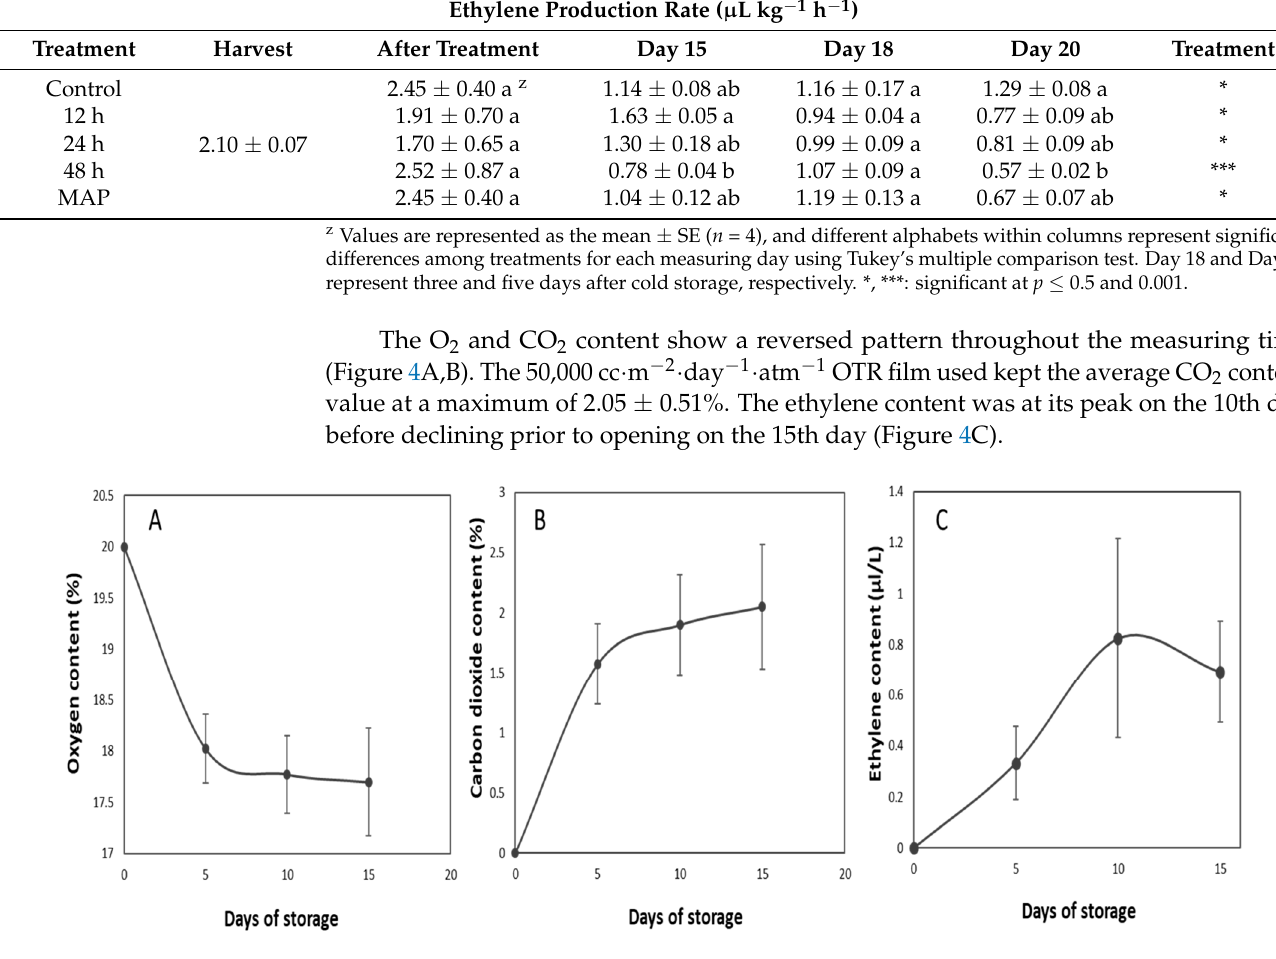
Table 2. Changes in ethylene production rates of sweet peppers pretreated with 10% CO 2 for 12, 24, and 48 h, as well as untreated and modified atmosphere packaging (MAP) with